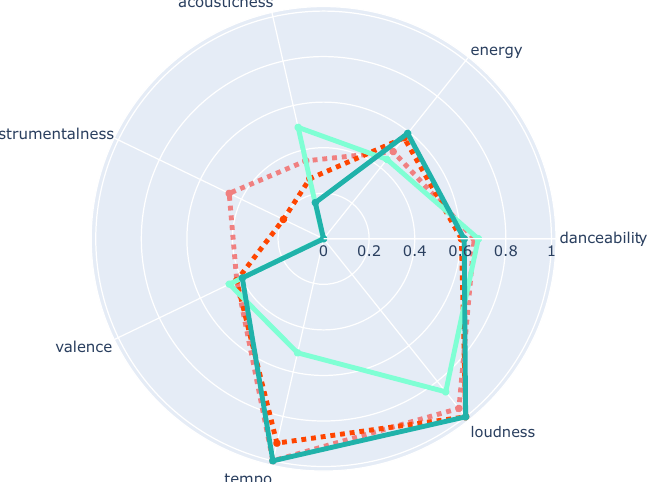
Figure 1. Radar plot of 7 audio features of Study clusters 1 (‘Pop Tracks’) and 3 (‘Lo-fi Tracks’) and Sleep clusters 1 (‘Speechy Tracks’) and 2 (‘Radio Tracks’).